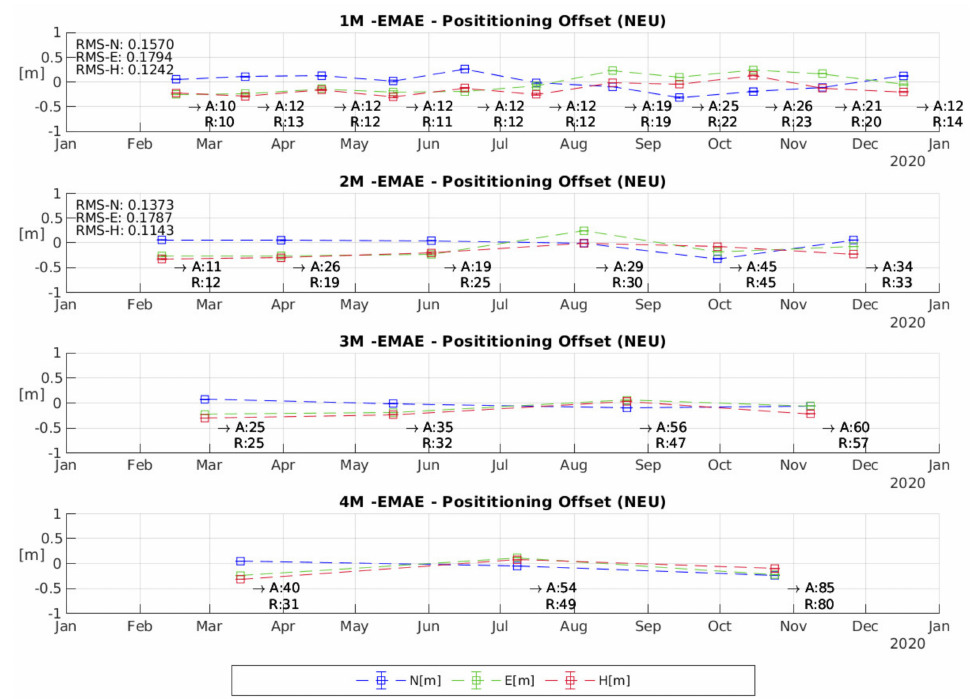
Figure 8. Positioning offset of the ECR located in Emäsalo for the different temporal resolutions derived from SAR data: monthly (1 M), bimonthly (2 M), trimonthly (3 M), and every four months (4 M) in the year 2020. The offsets are displayed in local North (blue), East (green), and Height (red) with respect to given reference coordinates from GNSS campaigns at the mean date of each observation period. For 1 M and 2 M, the Root Mean Square (RMS) values in meters are displayed in the top left corner of the respective graph. “A”: and “R”: beneath each solution indicate the number of radar measurements used in azimuth and range for the particular